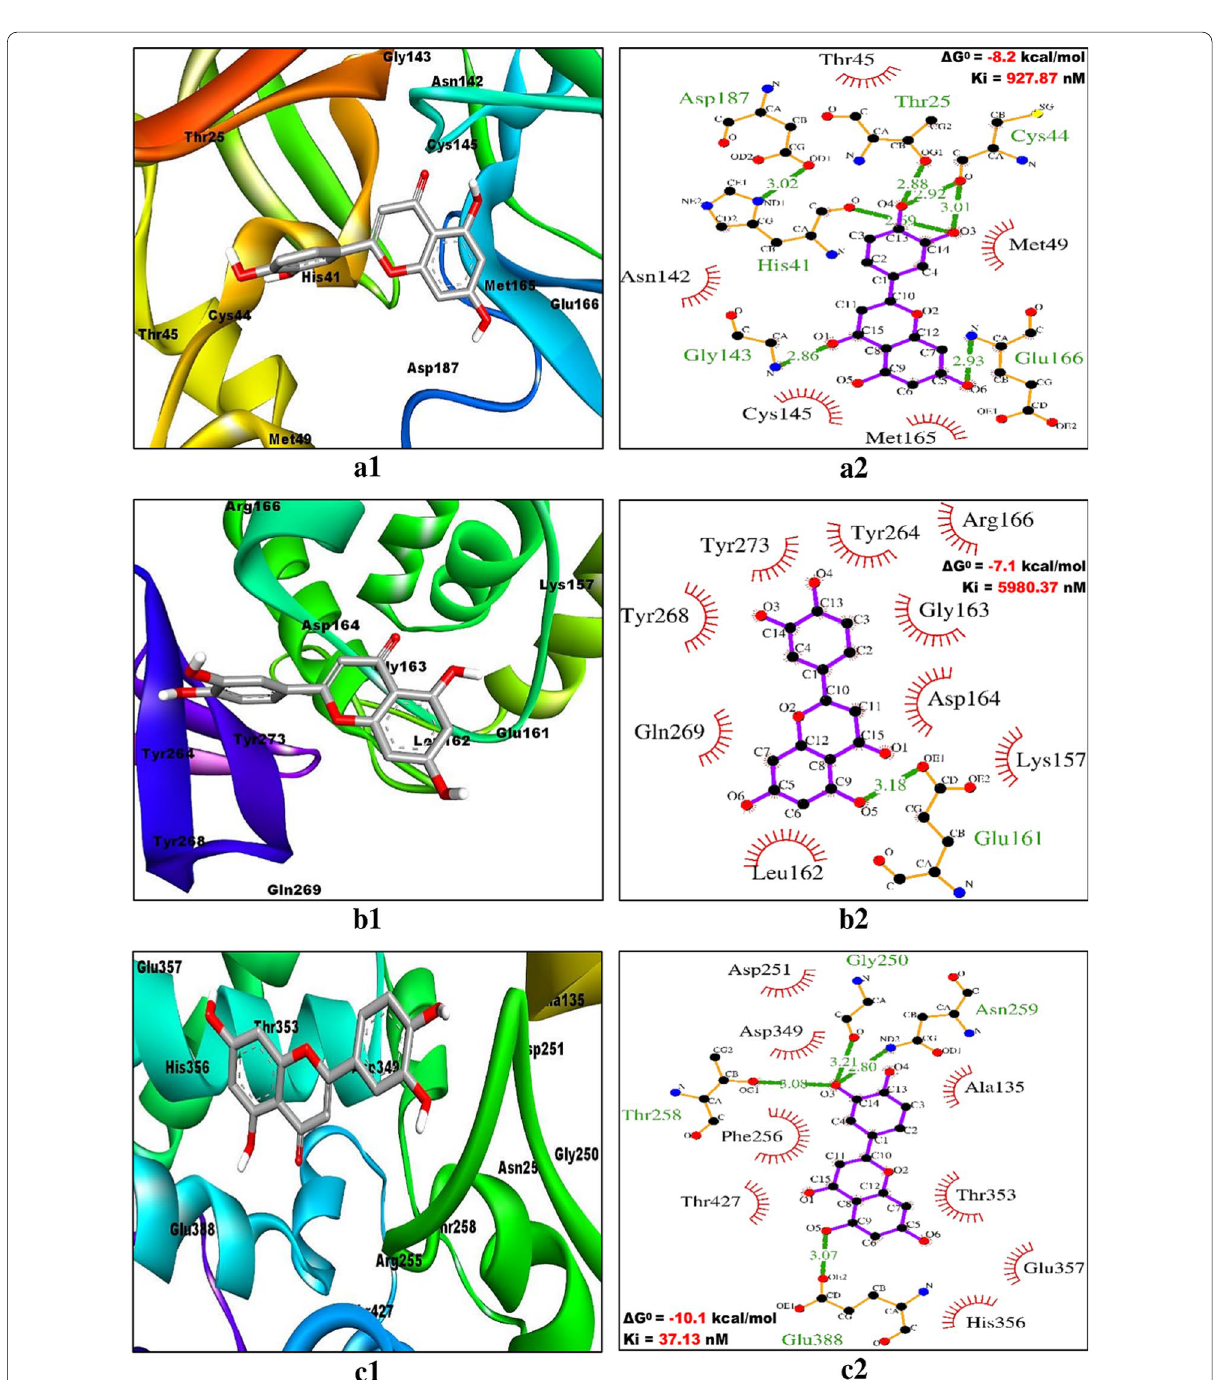
Fig. 3 Binding poses (within the active site) and molecular interaction between C3/luteolin and different targets of COVID-19. a1 , a2 C3/luteolin and Mpro/3CLpro, b1 , b2 C3/luteolin and PLpro and c1 , c2 C3/luteolin and ACE2. Inside the active site, targets are illustrated as solid ribbon and the bound ligands as stick. The molecular interactions are represented by the green dashed lines for hydrogen bonds and semi-arcs with red eyelashes for hydrophobic